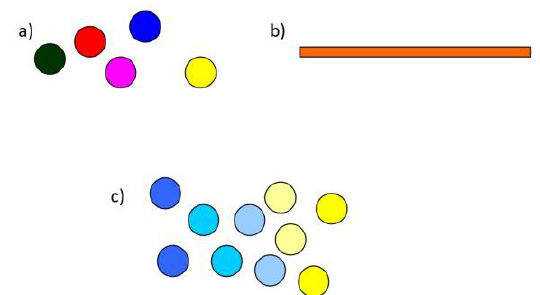
Figure 7. Available visualisation styles: Point style (a) and line style (b) with individual colour for each detected person; (c) point style with gradient colour scheme based on time for whole